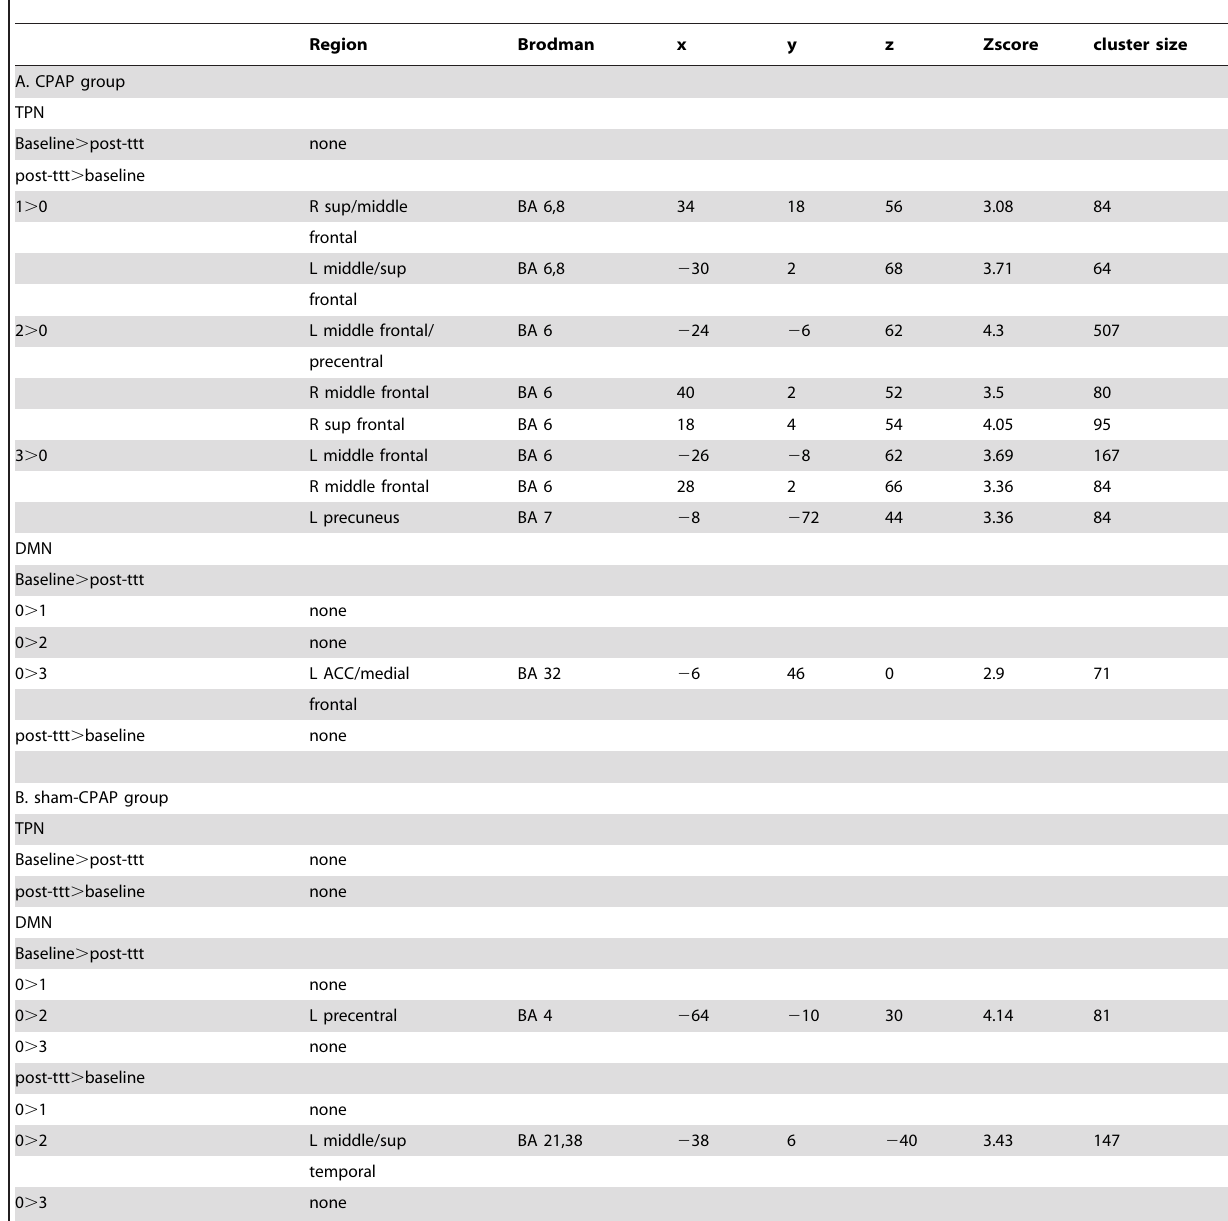
Table 3. Therapeutic and sham-CPAP effects: cerebral regions showing significant task-related activation and deactivation in TPN and DMN regions on paired t-test in 1vs0, 2vs0 and 3vs0 contrasts in A) the active CPAP group and B) sham-CPAP group (MNI coordinates, corrected for multiple comparisons, p